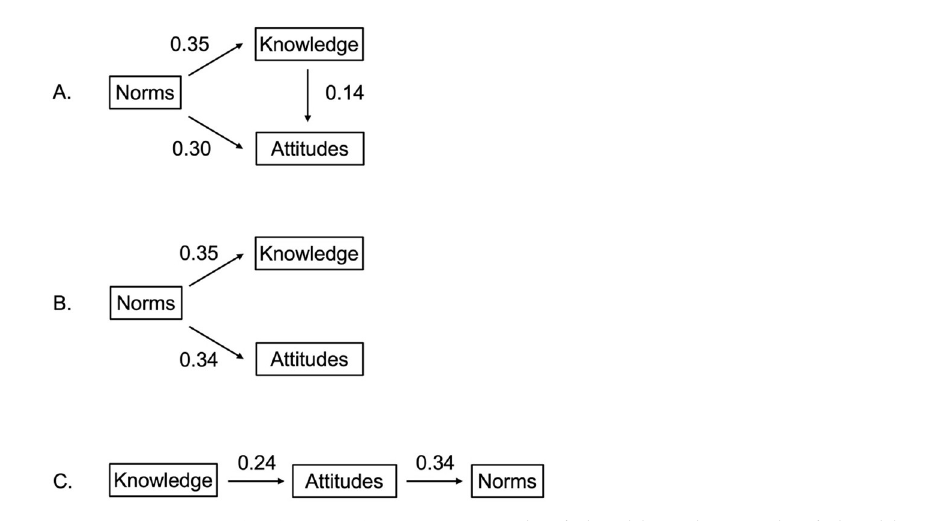
Fig 1. Models examined with standard estimates. A. Just identified model. B and C. Overidentified models. and 4) root mean square error of approximation (RMSEA; ranging from 0–1, with lower val-